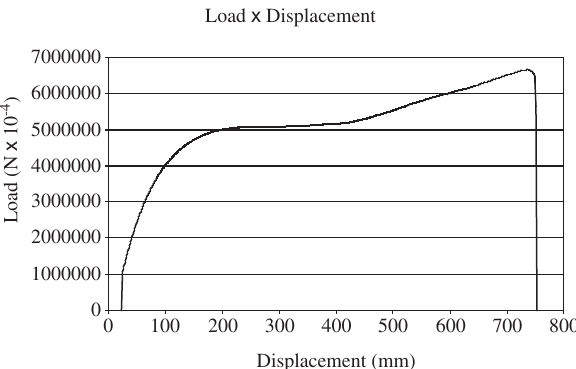
Figure 1. Representative load-displacement curve of recycled EVA specimen (160 °C and 100